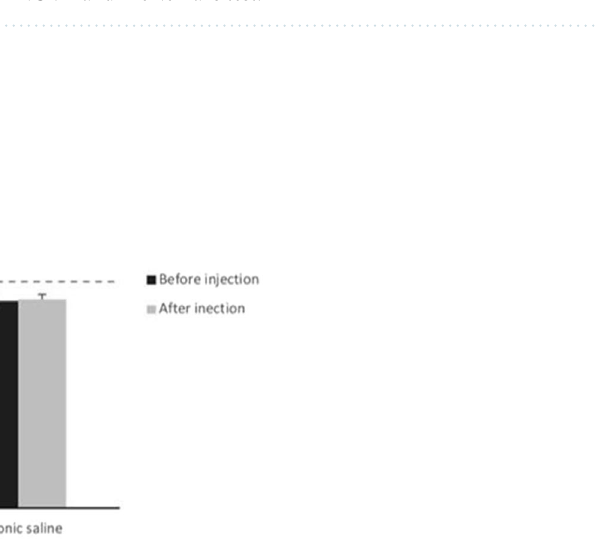
Figure 4. Perceived sensation intensity following mechanical stimulation of the masseter muscle. The vertical bars represent the mean perceived sensation intensity (PSI) scores recorded during the palpation of the masseter muscle. A statistically significant difference was found between the before glutamate and after glutamate session, * P < 0.05, ANOVA. Error bars represent the standard error of the